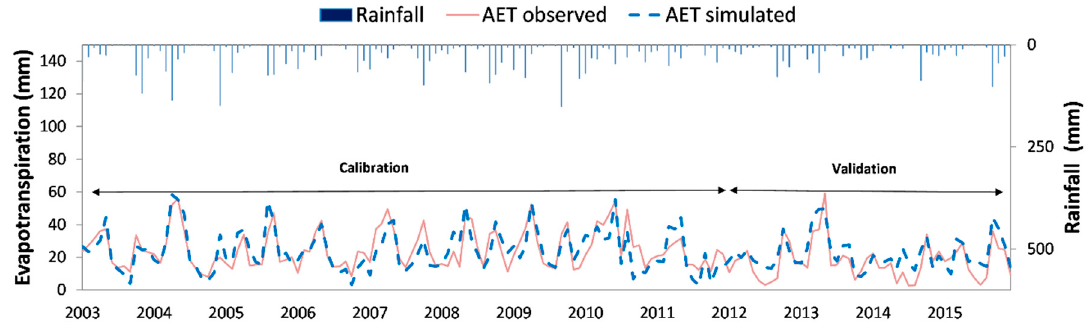
Figure 2. Comparison of simulated and observed actual evapotranspiration of the El Beal watershed for the calibration and validation periods.